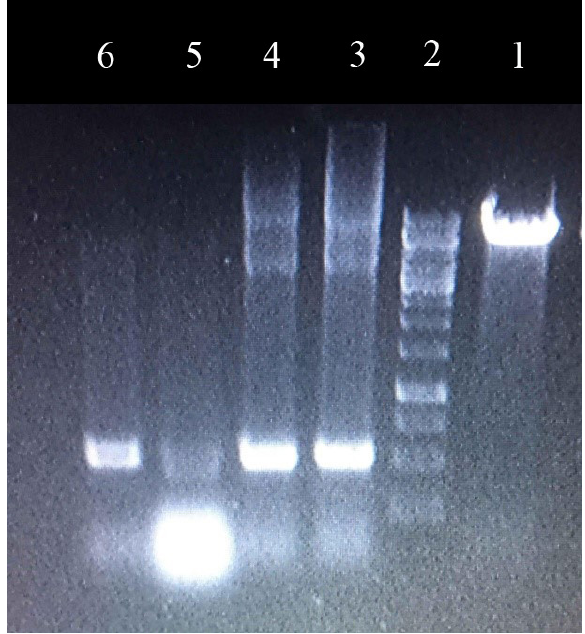
Figure 4. PCR product of the samples extracted from recombinant plasmid pcDNA-hIFN β 1a on agarose gel 1%. Line 1: plasmid pcDNA-hIFN β 1a. Line 2: 1kb DNA ladder line. Lines 3 & 4: Interferon-beta gene bands in the bp576